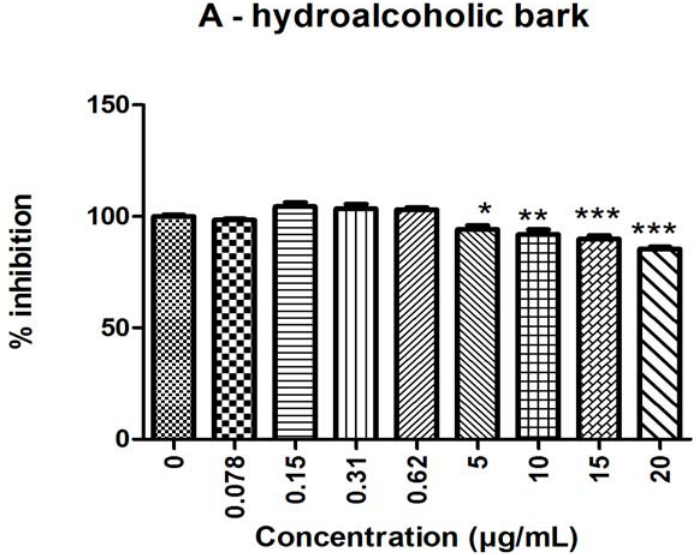
Figure 5. Effects of different extracts from S. rotundifolium on iron chelation: ( A ) hydroalcoholic bark; ( B ) aqueous leaves; ( C ) aqueous bark. Data show means ± SEM values average from 3 to 4 independent experiments performed in triplicate. *** p < 0.001 vs . Control; ** p < 0.01 vs . Control; * p < 0.05 vs .